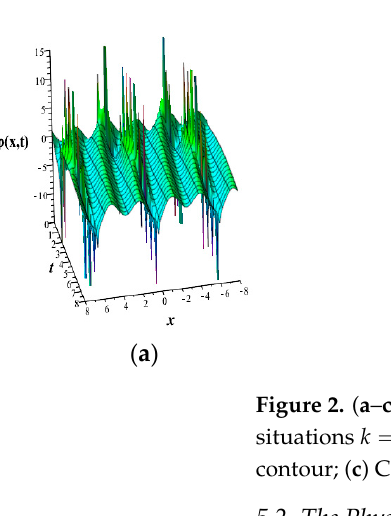
ϕ of Equation (23) for the parametric = t and 2 for 2D graph. ( a ) Real surface in 3D; ( b )